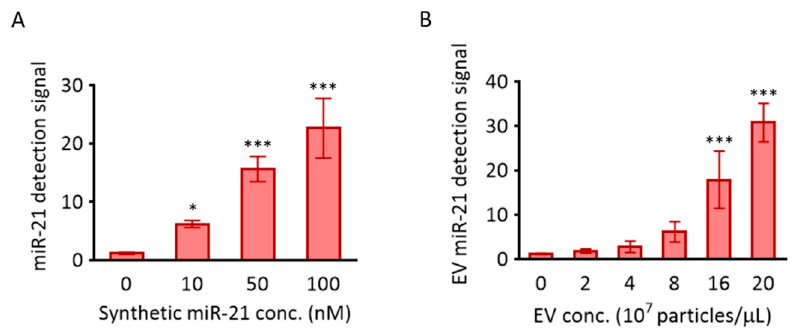
Figure 3. Detection of miR-21 using MB-21. The molecular beacon designed to target miR-21 was investigated for its hybridization to miR-21 in solution ( A ) and cancer EVs ( B ). ( A ) 100 nM MB-21 was incubated with different concentrations of synthetic miR-21 (0–100 nM), followed by measurement of the fluorescence signal using a fluorometer. ( B ) 100 nM of MB-21 was incubated with different concentrations of HeLa cell-derived EVs (0–20 × 10 7 particles/µL). All values are expressed as mean ± SD (* p < 0.05, *** p < 0.001; n = 3–6).